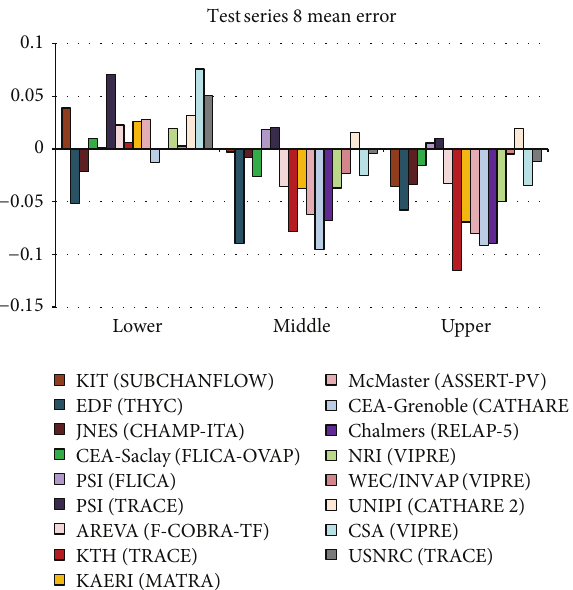
Figure 27: Test series 7 void fraction mean error.